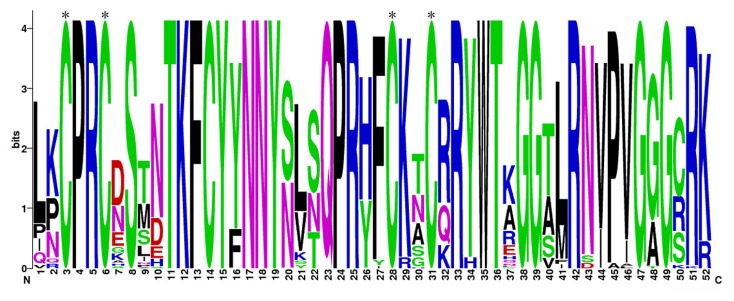
Dof domains are highly conserved across all Dof proteins in soybean.The sequence logos are based on alignments of all soybean Dof domains. Multiple alignment analysis of 78 typical soybean Dof domains was performed with ClustalW. The bit score indicates the information content for each position in the sequence. Asterisks indicate the conserved cysteine residues (Cys) in the Dof domain.